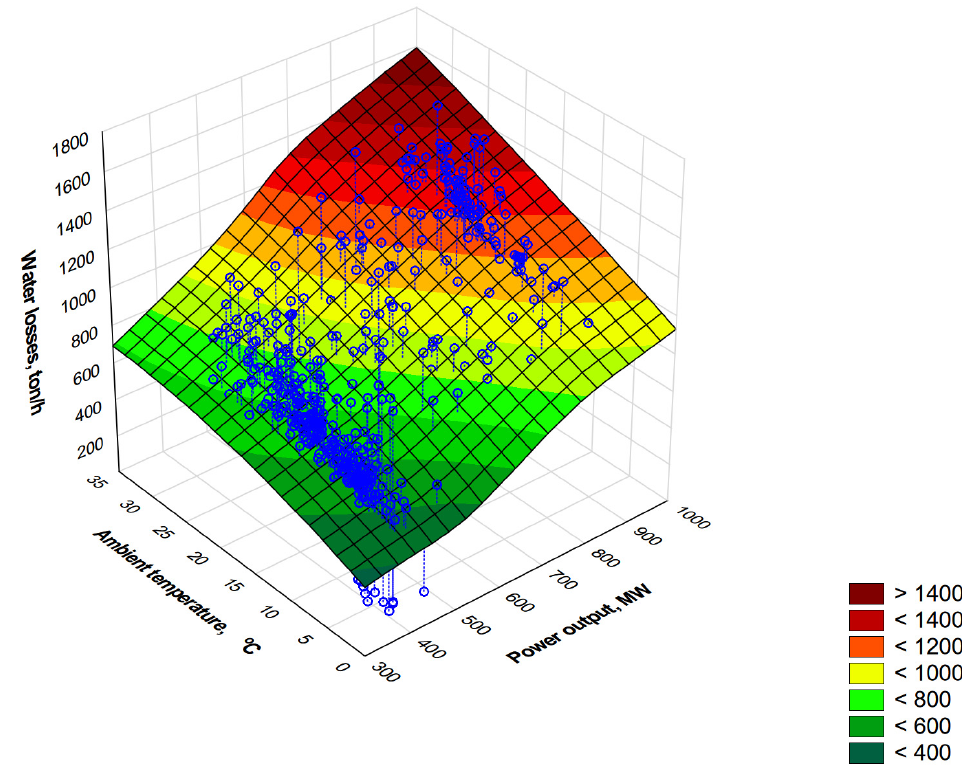
Figure 6. Effect of unit power and ambient temperature on the sum of evaporative and drift losses.